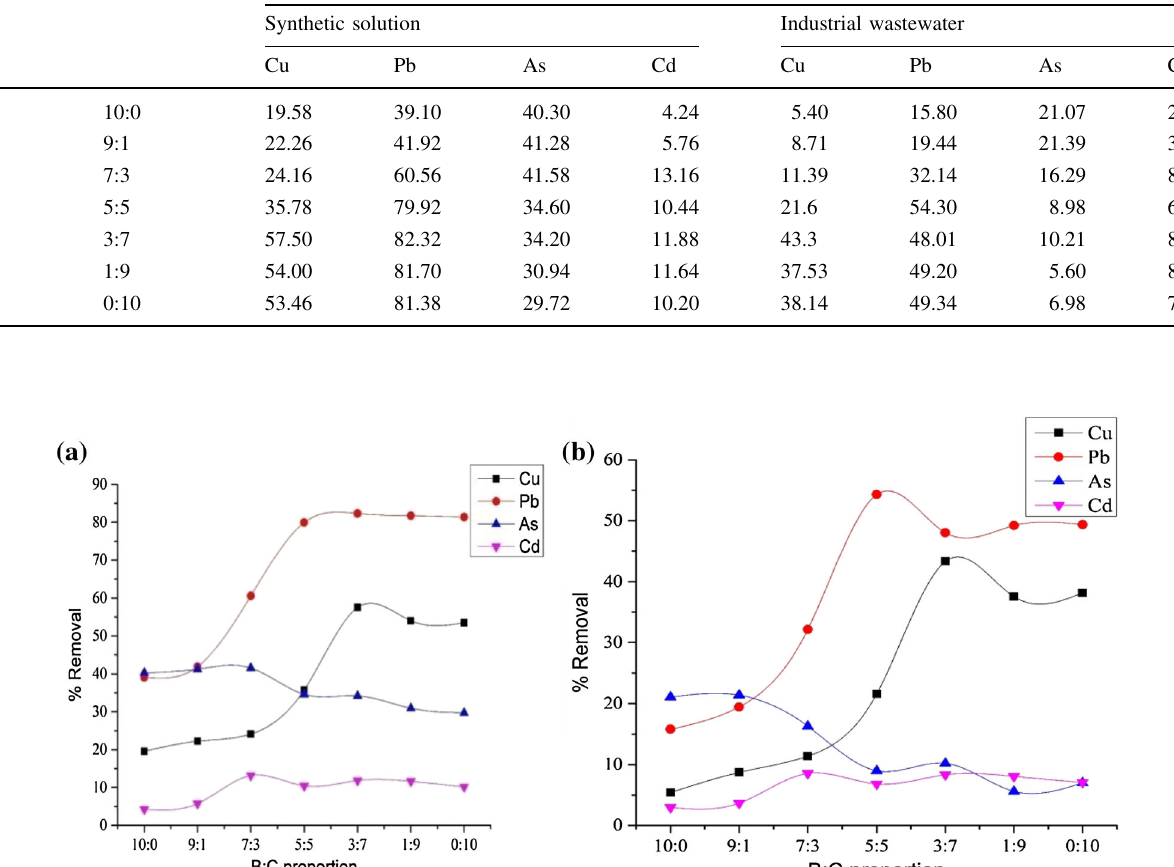
Table 4 Comparison of heavy metals removal from synthetic solution and industrial wastewater S. no.